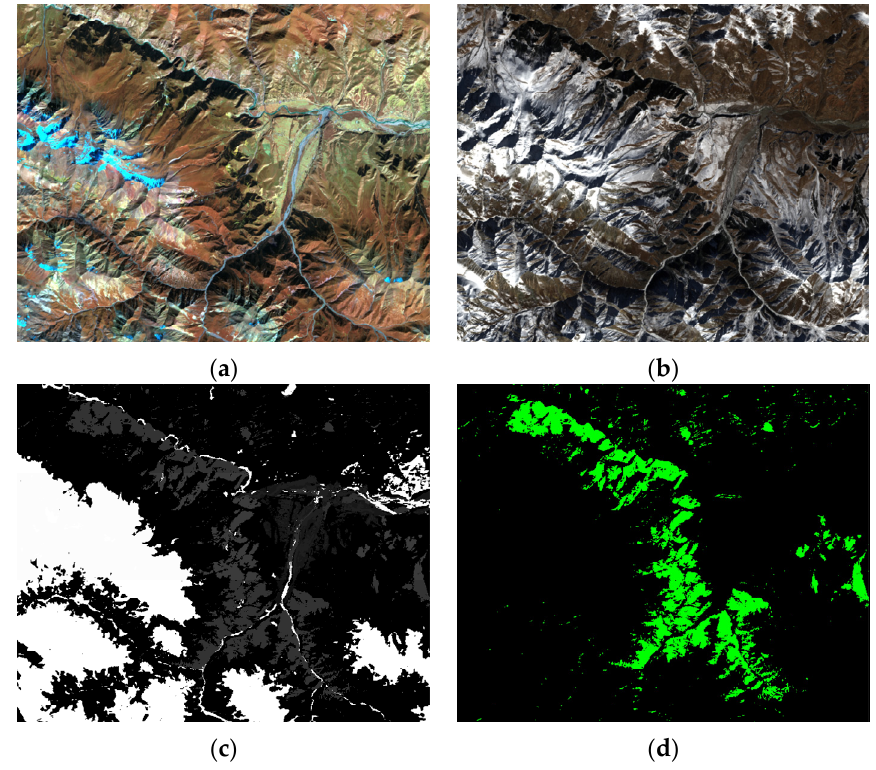
Figure 2. Landsat OLI false color composite image (( a ) is acquired on 18 October 2013; ( b ) is acquired on 7 February 2014) and classification map ( c ) of the study site; ( d ) shows the forests in green.